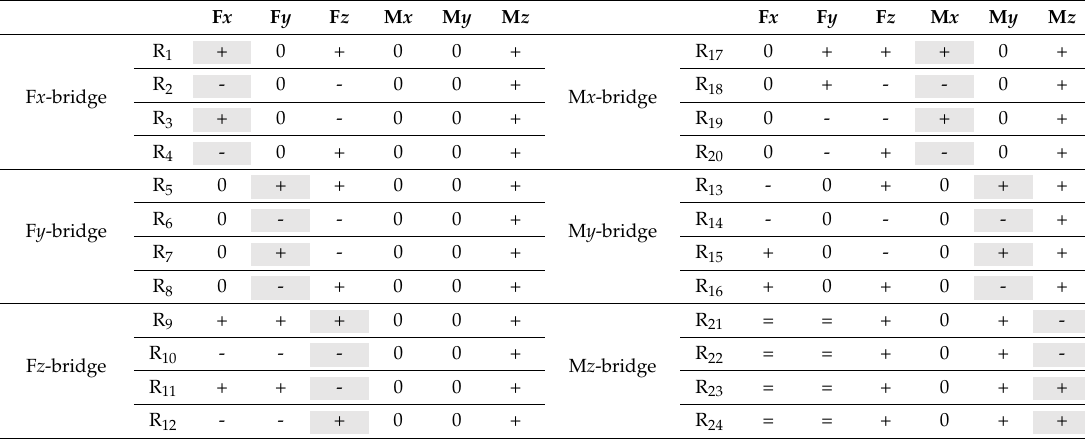
Table 4. Variations of resistances of strain gauges.